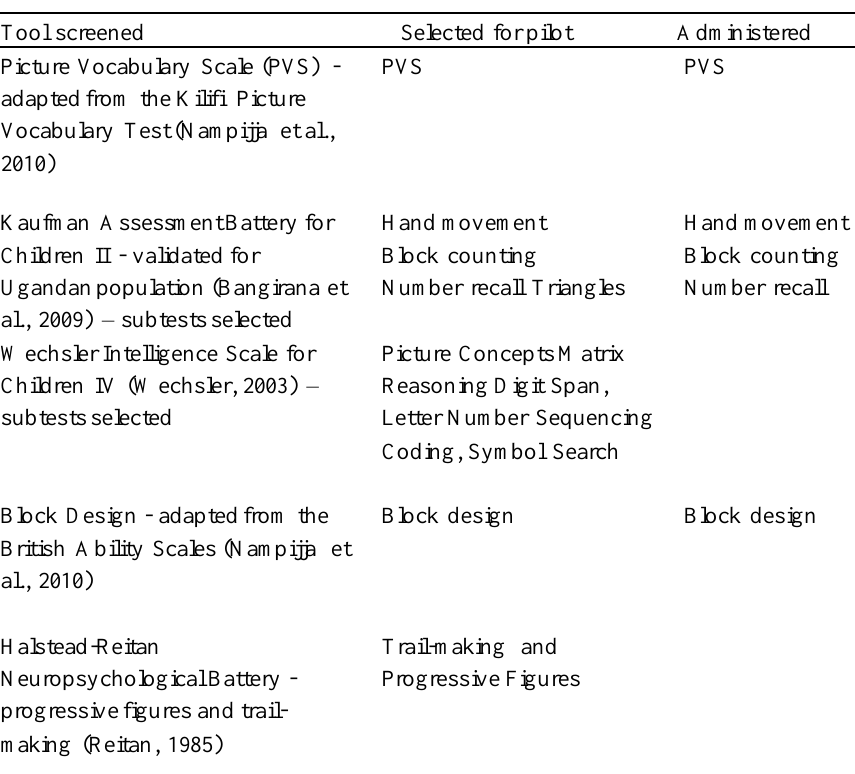
Psychometric Assessment Tools Screened, Piloted, and Administered Tool screened Selected for pilot Administered Picture Vocabulary Scale (PVS) - PVS PVS adapted from the Kilifi Picture Vocabulary Test (Nampijja et al.,